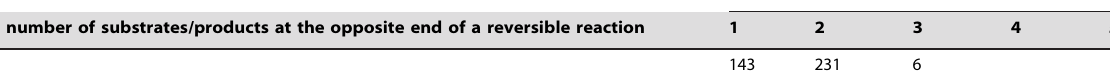
The number of substrates/products at the opposite end of a reversible